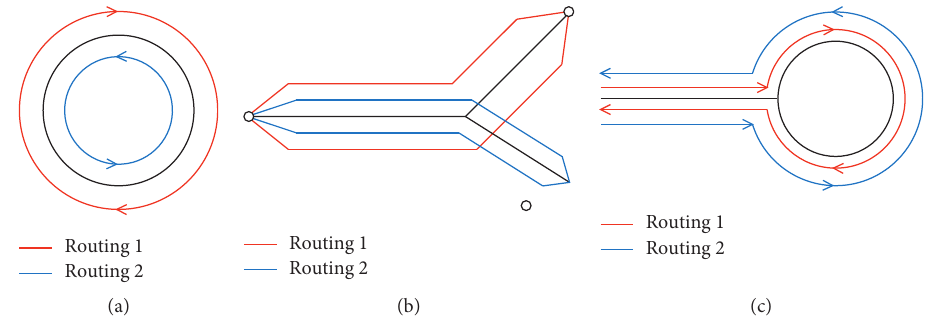
Figure 3: Routing plans of 3 different shaped